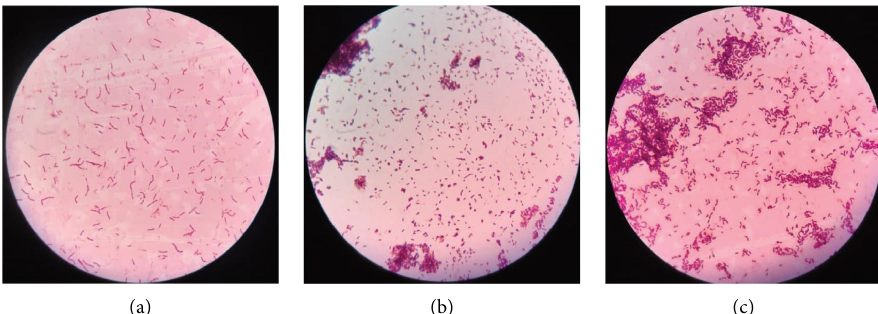
Figure 1: Gram-positive microscopic observation of some isolates (1000X): (a) isolate BKTD; (b) isolate BKHA; (c) isolate BKHE.